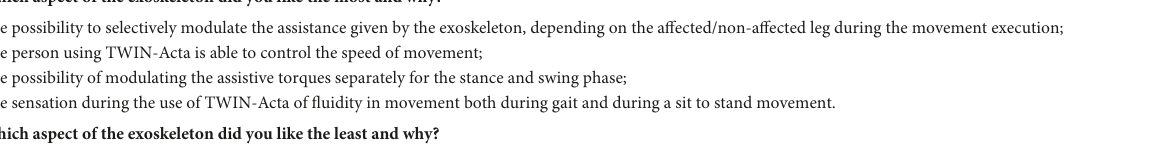
Which aspect of the exoskeleton did you like the most and